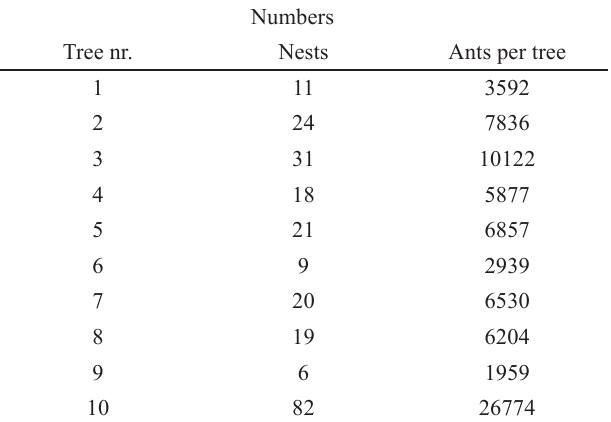
Table 2 . Estimated number of worker ants in 10 different trees.